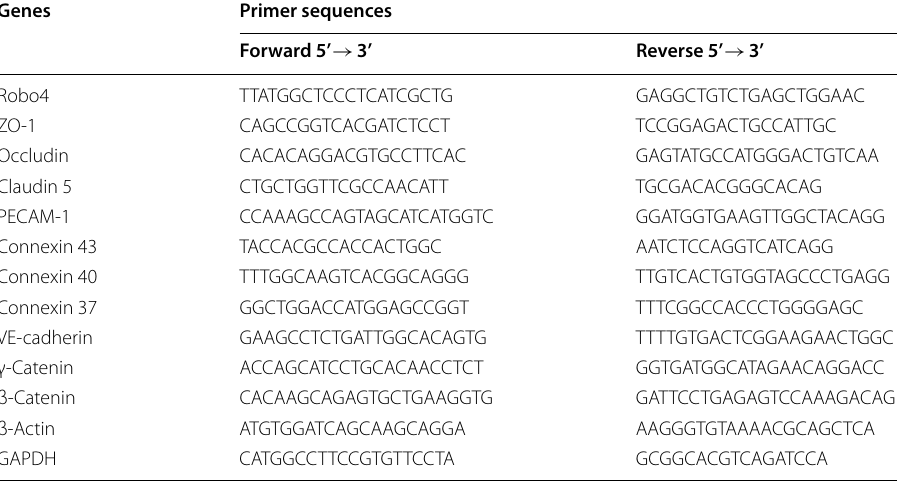
Table 1 Real-time quantitative PCR primer